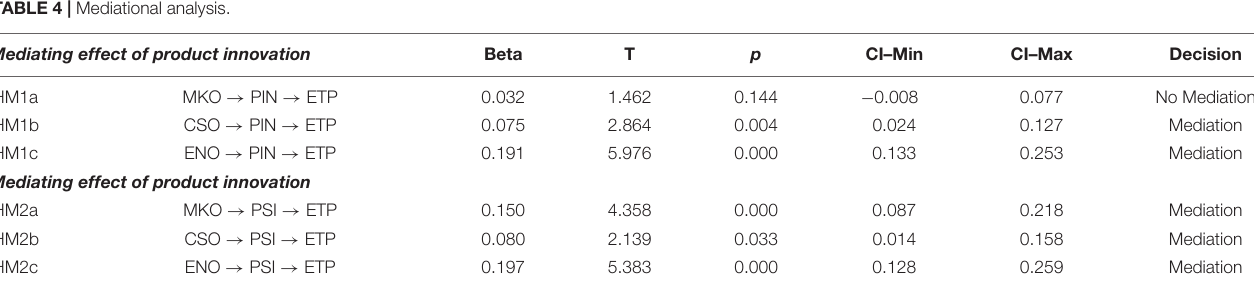
TABLE 4 | Mediational